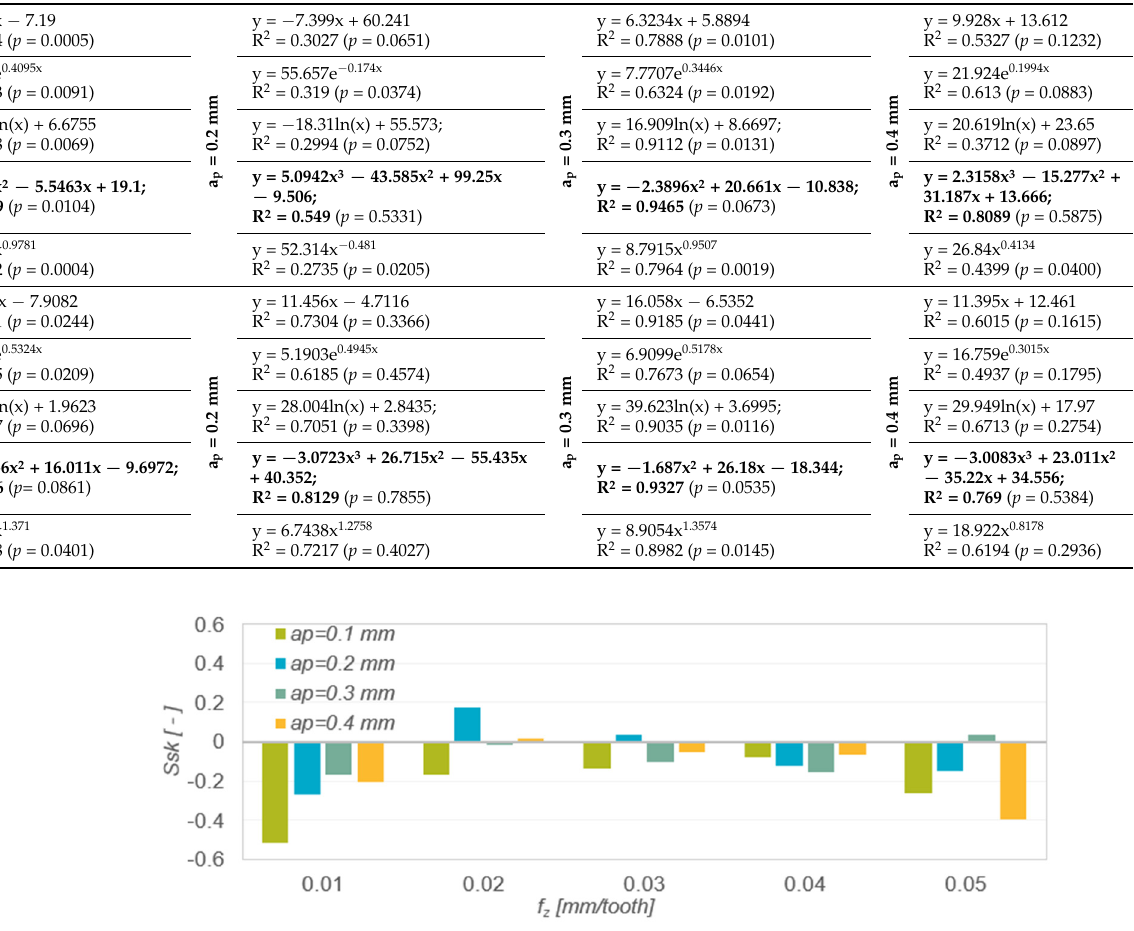
Figure 6. The results of measurements of roughness parameter Ssk as a function of feed per tooth f z and depth of cut a p.